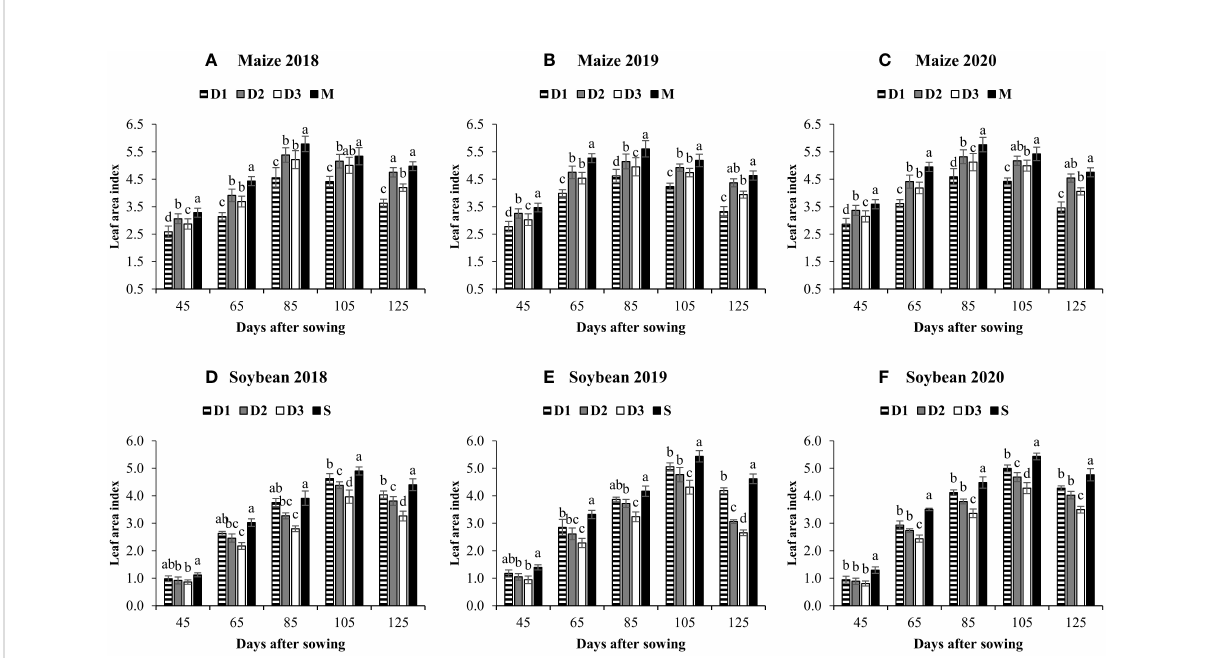
FIGURE 3 Leaf area index of maize (A – C) and soybean (D – F) in response to different maize planting densities (6 maize plants m -2 , low, D 1 ; 8 maize plants m -2 , medium, D 2 ; and 10 maize plants m -2 , high, D 3 ) under maize/soybean strip intercropping. Bars show ± standard errors (n = 3). The different lowercase letters within a bar show a signi fi cant difference (p < 0.05) among treatments. The M and S represent the sole maize and soybean,